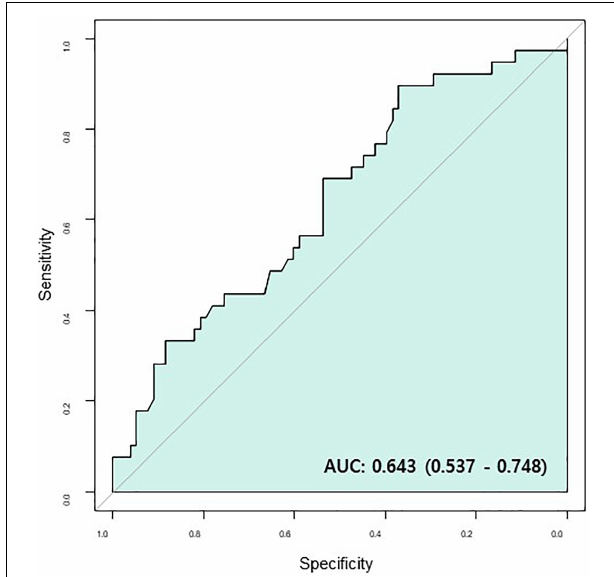
FIGURE 2 | Survival ROC of (cid:49) [LV GLS]. AUC, area under curve; CR, complete response; (cid:49) [LV GLS], post-chemotherapy [LV GLS]—pre-chemotherapy [LV GLS]; ROC, receiver operating characteristic.